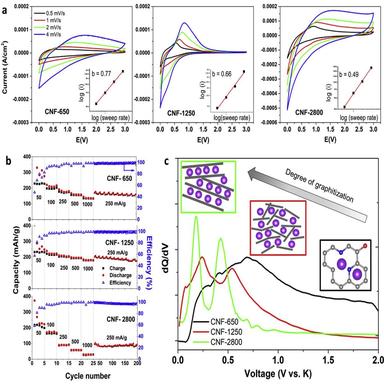
Correlation between the microstructure and potassium ion storage. (a) Voltammetric responses for CNFs at sweep rates 0.5, 1, 2 and 4 mV/s, the inset is fitting of the voltammetric sweep data using Eq.. (b) Rate capability and cyclic performance of CNF films at current densities ranging from 50 to 1000 mA/g (c) dQ/dV curves of CNF films at the oxidation. The inset shows the illustrations of main K-ion storage mechanism in three different regions. (A colour version of this figure can be viewed onl